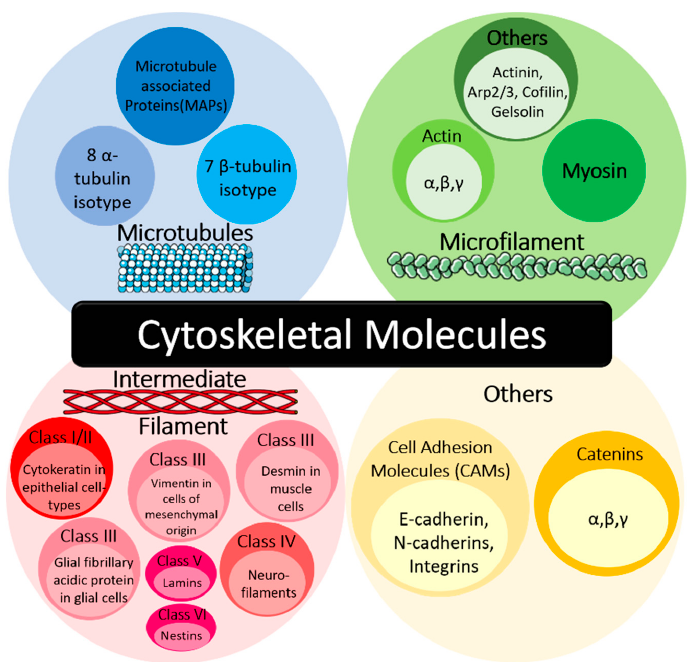
Figure 1. Classification of cytoskeletal molecules. The cytoskeletal molecules can be classified into three main classes, namely the microtubules, microfilaments and intermediate filaments. Within each main class of molecules, it can be further categorised based on its function and molecular type. In addition, there are also other cytoskeletal molecules that do not fall into the above groups, such as the cell adhesion molecules (CAMs) and catenin. Arp, actin-related